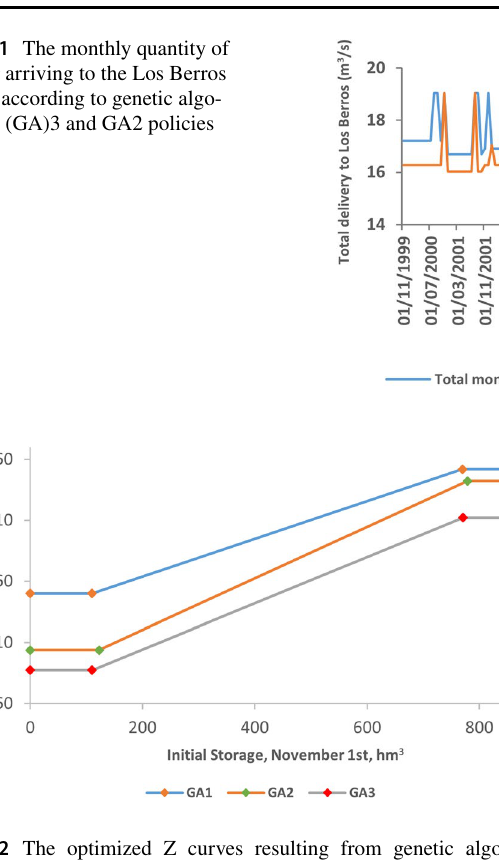
Fig. 22 The optimized Z curves resulting from genetic algorithm GA1, GA2 and GA3 policies